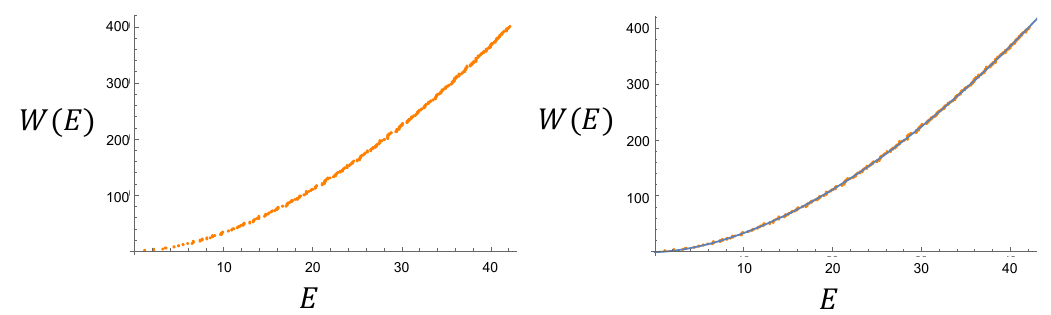
Figure 8 . Left: the number of states below the energy E , obtained by the eigenvalues of the quantum CHO Hamiltonian system. Right: the (cid:12)tting function W ( E ) = (cid:0) 1 : 08+0 : 64 E 1 : 72 overlaid on the point plots of the (cid:12)gure